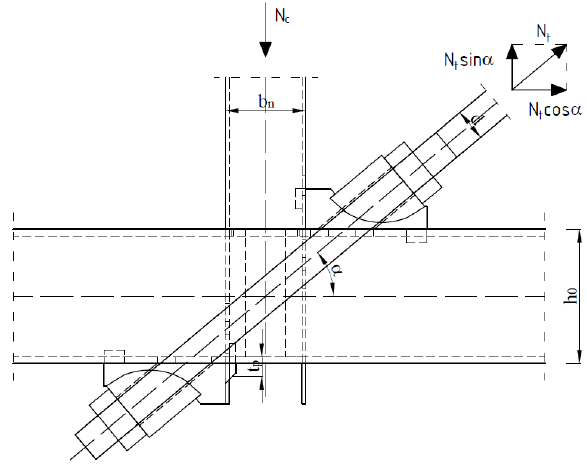
Figure 3: Load scheme of the joint (branch and bracing) The resistance of each component developed so far are presented as bellow.